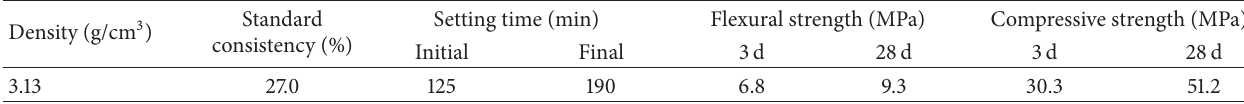
Table 1: Physical properties of used cement.